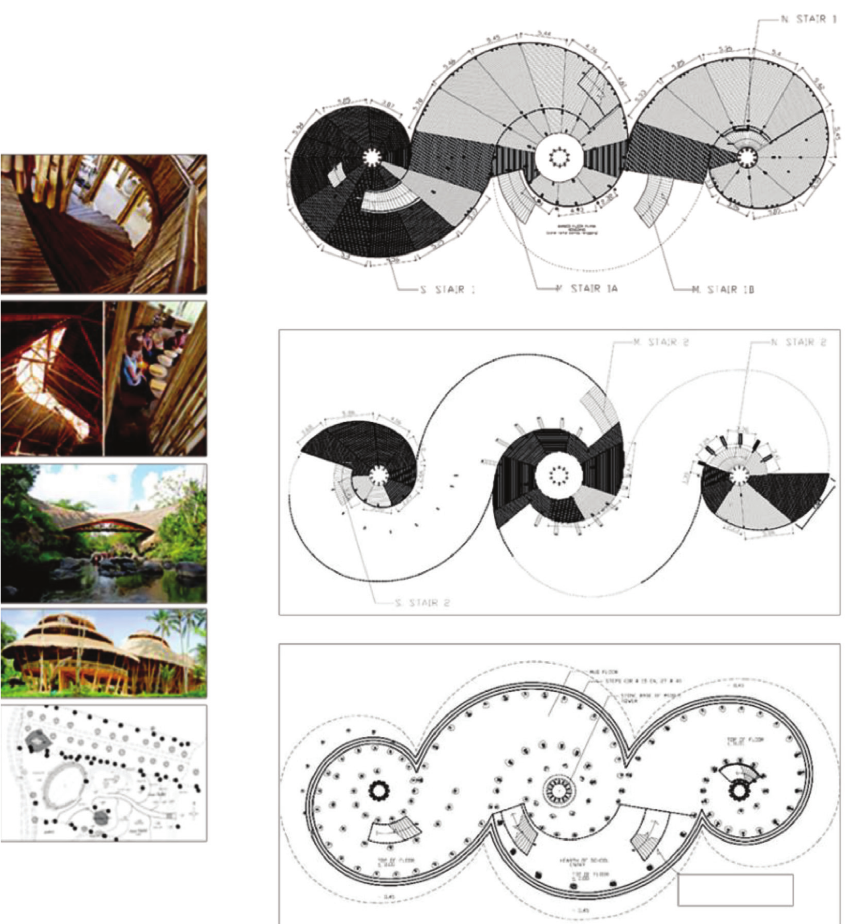
Figure 1: The basic plans and photos of the Green School in Bali.